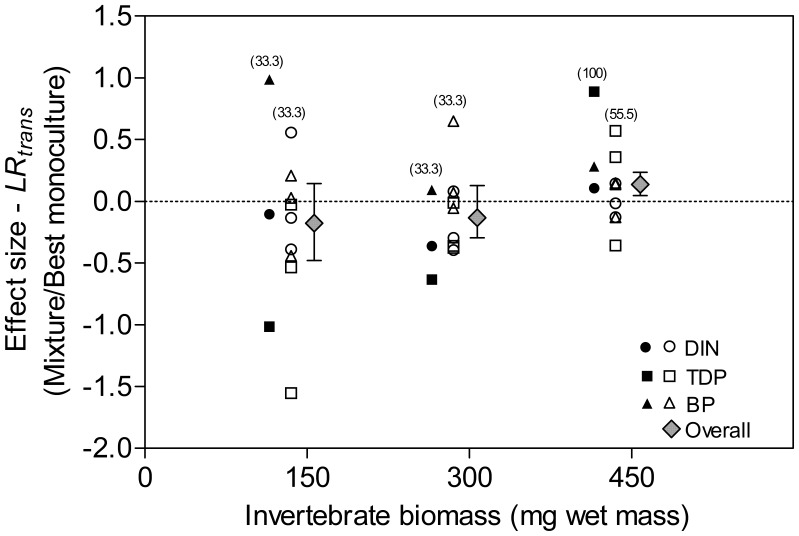
Transgressive overyielding for the ecosystem processes analyzed as a function of invertebrate biomass.Diversity ‘effect sizes’ (standardized ln response ratios) were estimated for individual ecosystem processes for each biomass level by comparing the proportional response of 2- (open symbols) and 3-species mixtures (filled symbols) to their respective best constituent monoculture. Overall cumulative effect sizes (gray diamonds) and their ±95% bootstrapped CI’s were calculated from the weighted integration of the individual effect sizes calculated for all combined ecosystem processes and species richness treatments throughout 9999 iterations. Significant overall transgressive overyielding occurs if the value of LRtrans and its confidence interval are greater than zero (dashed line). Numbers in parentheses represent the proportions of treatments with LRtrans >0 for the respective invertebrate biomass and species richness levels. Abbreviations for ecosystem processes are as in figure 2.